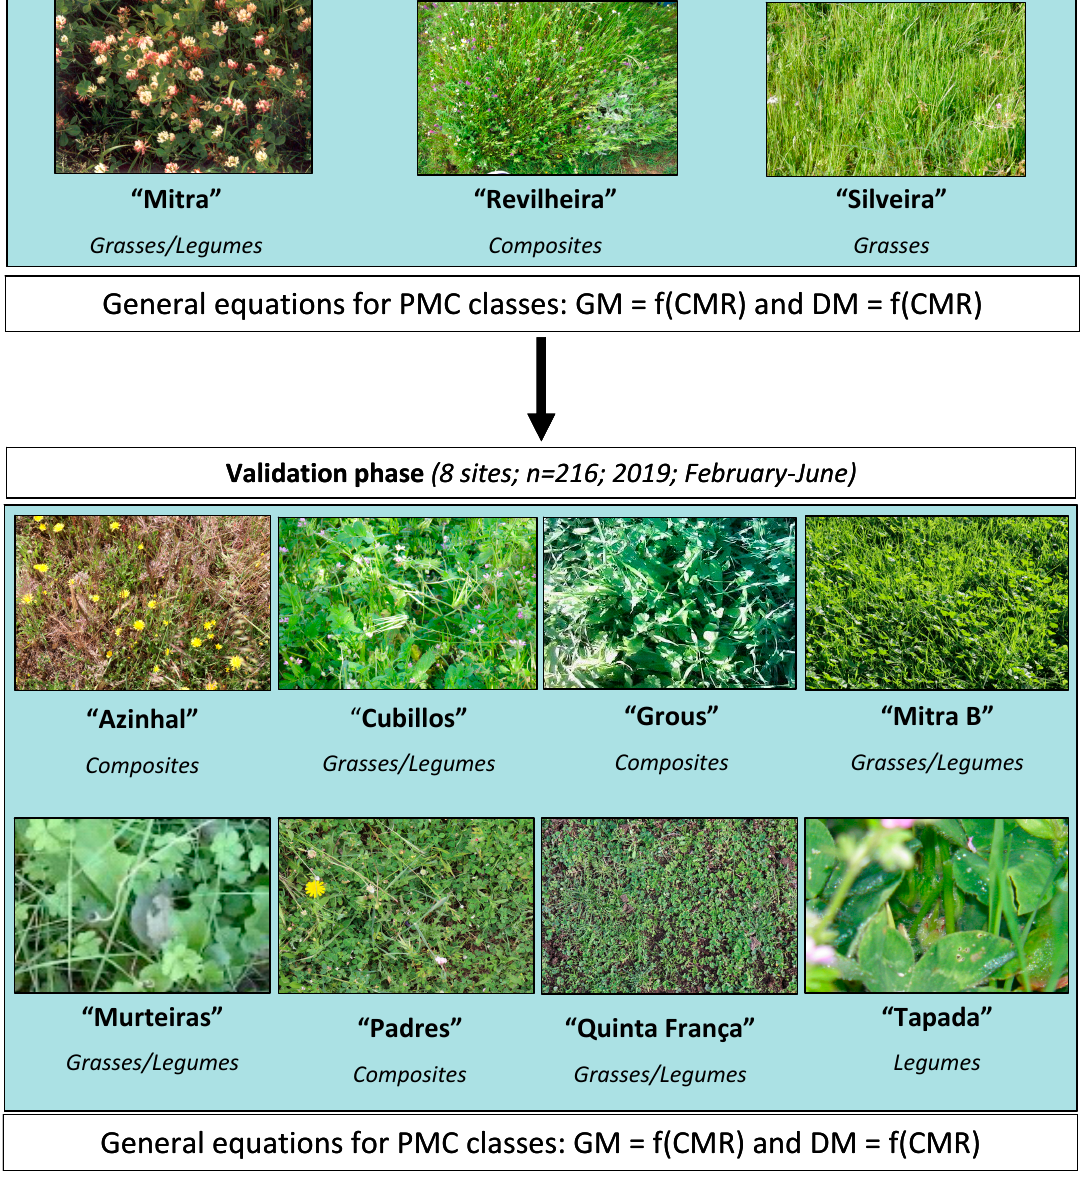
Figure 3. Schematic representation of the experimental methodology used in this work.